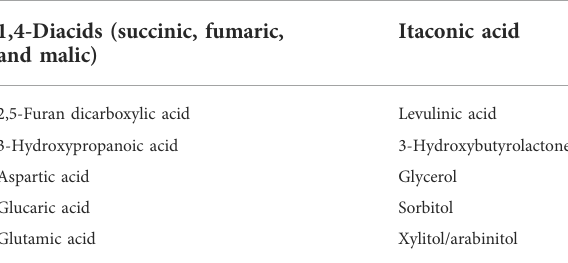
FIGURE 6 Valuable products from carbon dioxide, color-coded accordingtothecurrentstageofdevelopmentintheirproduction, i.e., laboratory scale (orange), demonstration plant (blue), and commercial stage